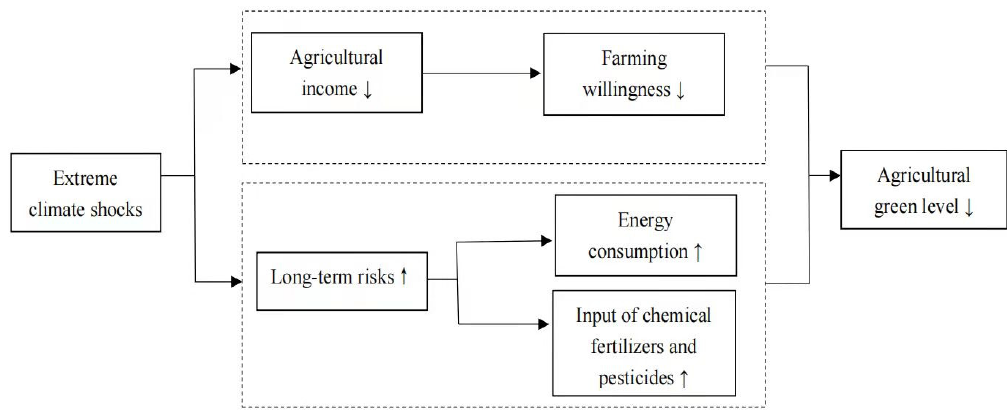
Figure 1. Impact of extreme climate shocks on green agricultural development (GAD).